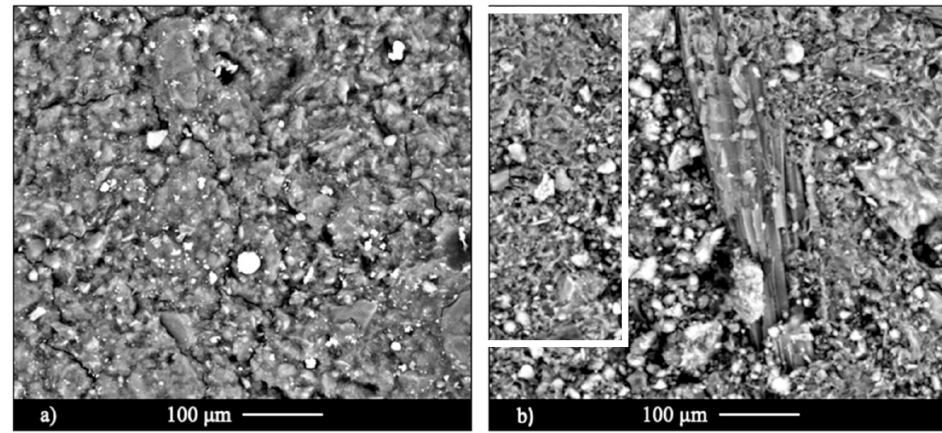
Figure 10. Internal surface ( a ) of MK 100%; Internal surface ( b ) of MK + 70%biochar.